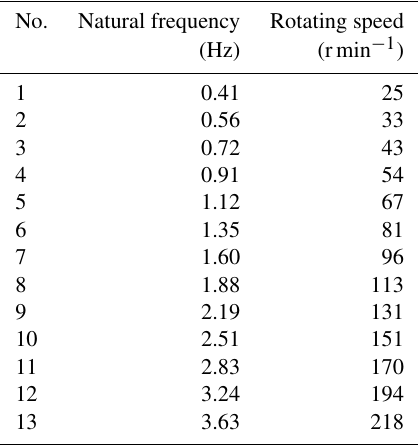
Table 2. Natural frequency of the BHA.